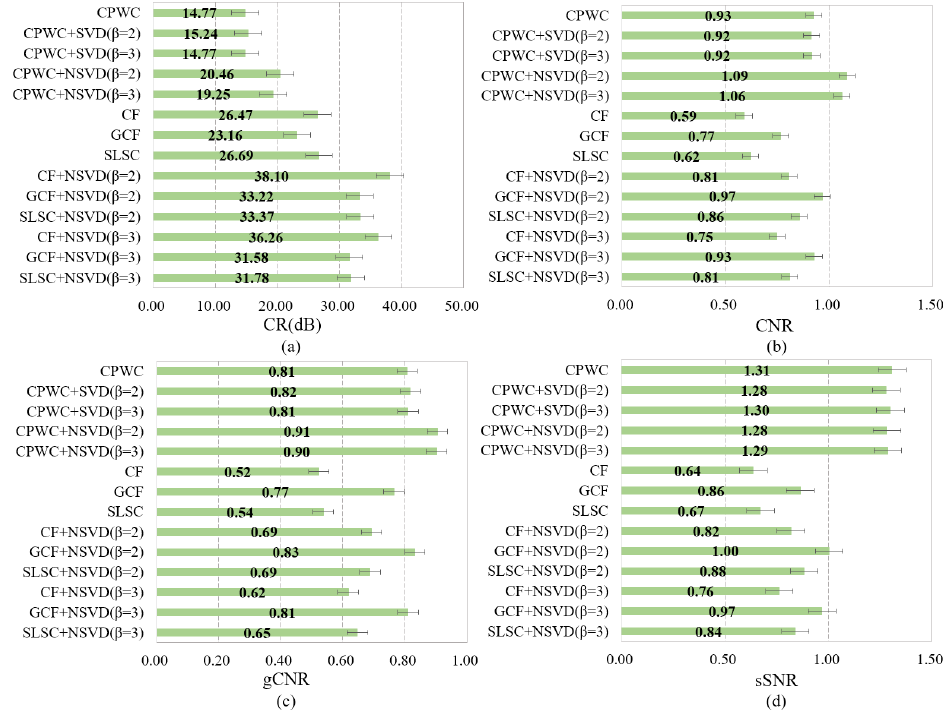
Figure 16. Barplot of ( a ) CR, ( b ) CNR, ( c ) gCNR, ( d ) sSNR calculated for different method with the in vivo